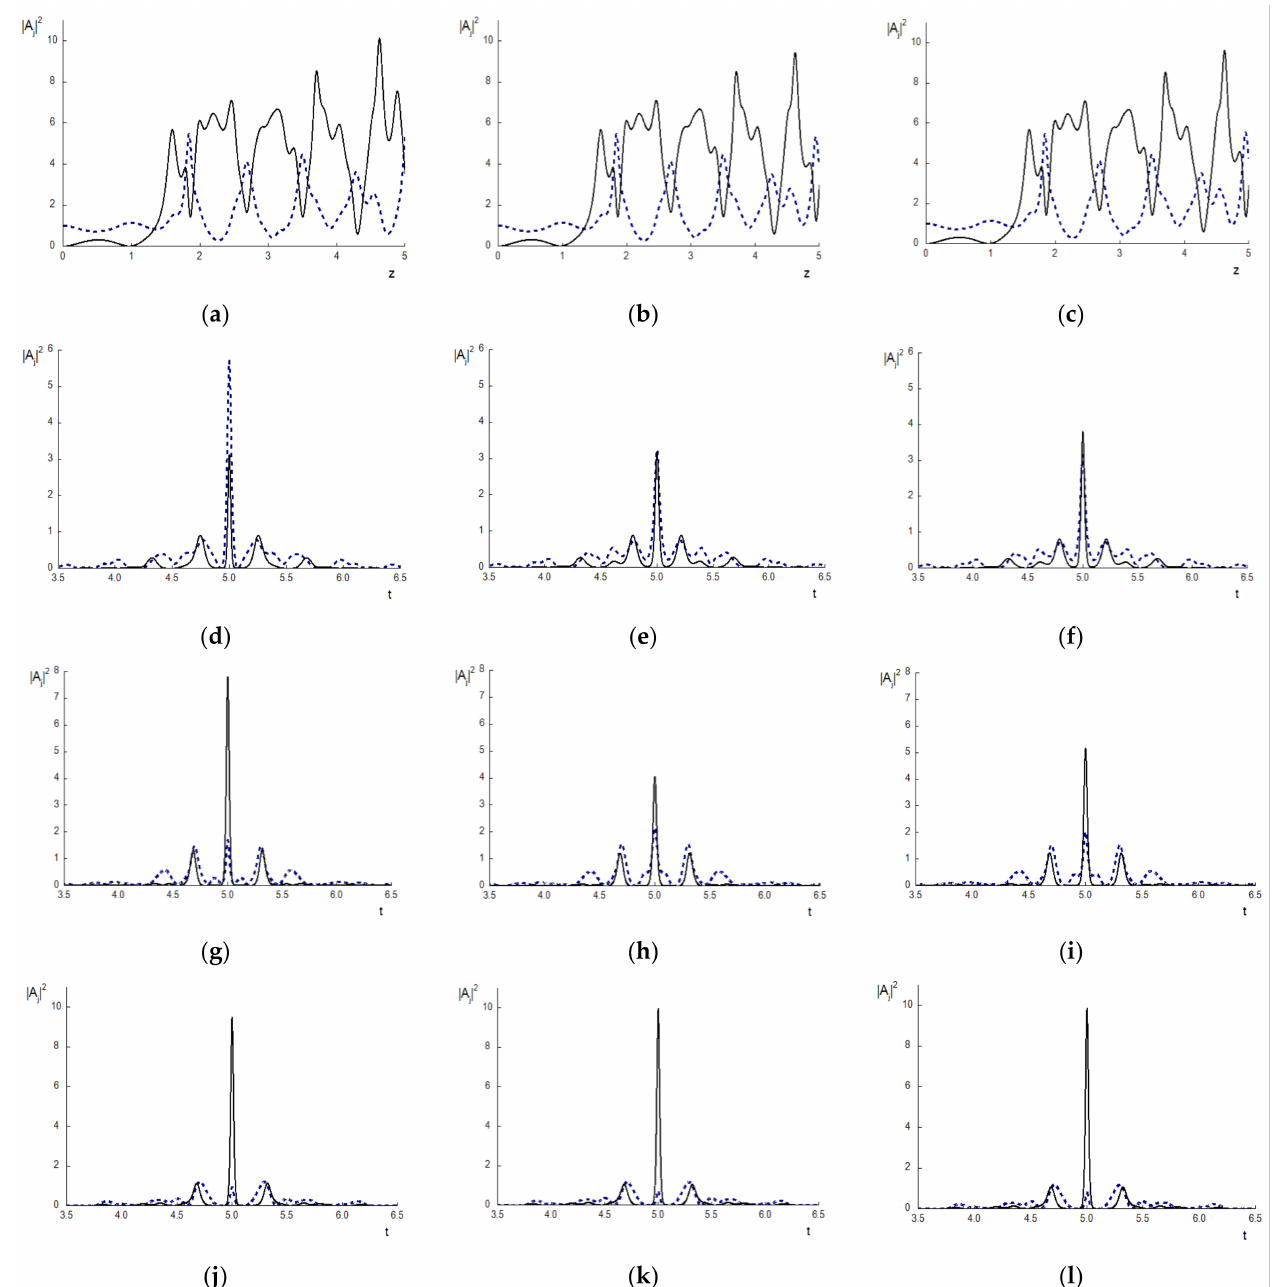
Figure 5. The intensity evolution at the pulse center ( a – c ) and pulse shapes in sections z = 5 ( d – f ), 6 ( g – i ), 5.5 ( j – l ), for the BW (dashed line) and the TH wave (solid line) computed using the CFDS-I3 ( a , d , g , j ), ISSM ( b , e , h , k ), and SSMRK ( c , f , i , l ) with h = 0.002, ( a – f ) and 0.0002 ( g – l ),